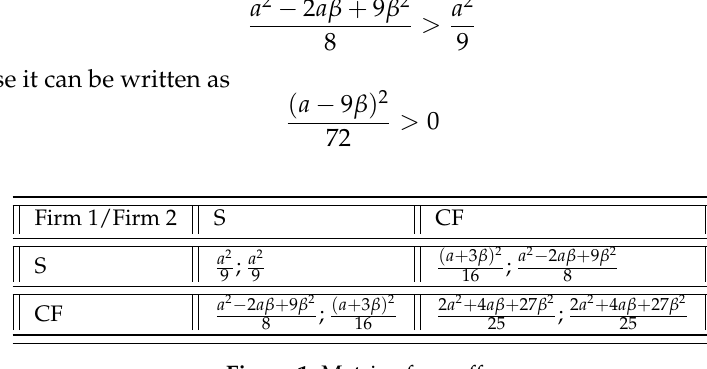
Figure 1. Matrix of